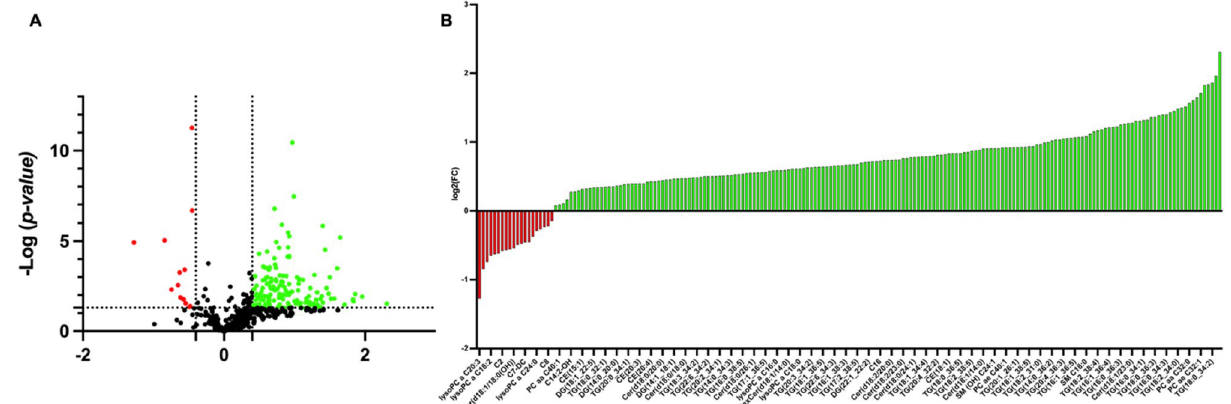
Figure 2. Volcano plot analysis of lipids significantly different in CF patients. ( A ) The relative abundance of each lipid was plotted against its statistical significance, respectively reported as log FC (log2 fold change) and − log10 (p-value). Red and green dots indicate features that presented both a FC > 1.5 and p-value < 0.05. Black dots refer to all the lipids identified in the dataset whose relative abundance are not significantly different between patients with CF and healthy controls. ( B ) Red and green bars refer to significantly decreased and increased lipids, respectively.